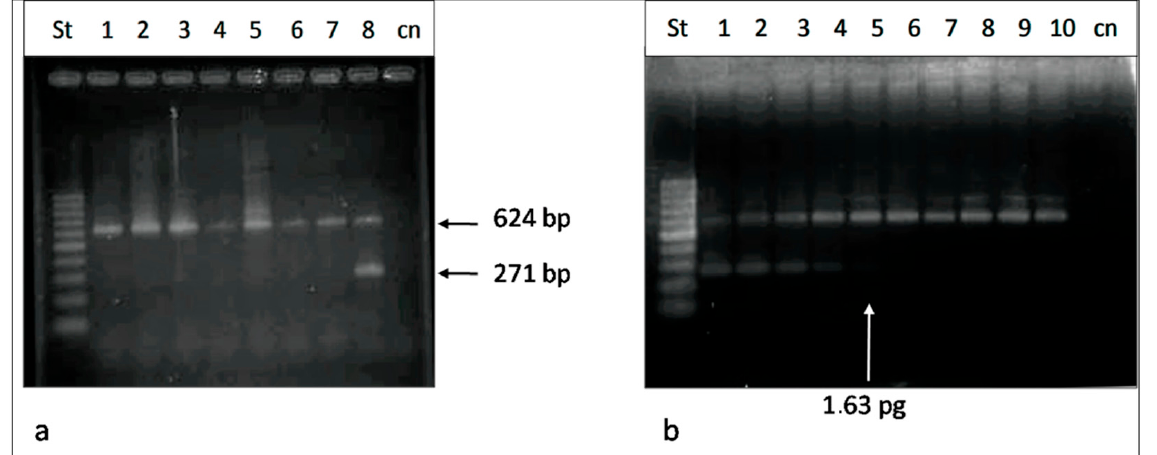
Figure 2. ( a ) Specificity assay using primers specific for the bacteriocin operon of Streptococcus downii